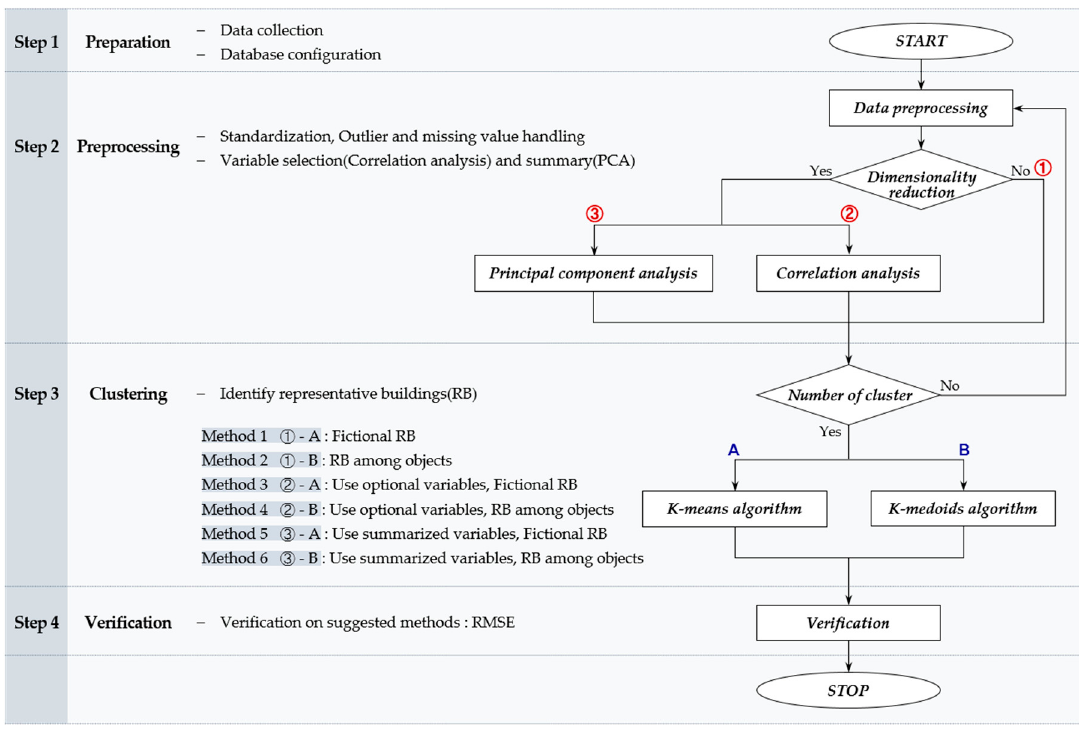
Figure 1. The study process.